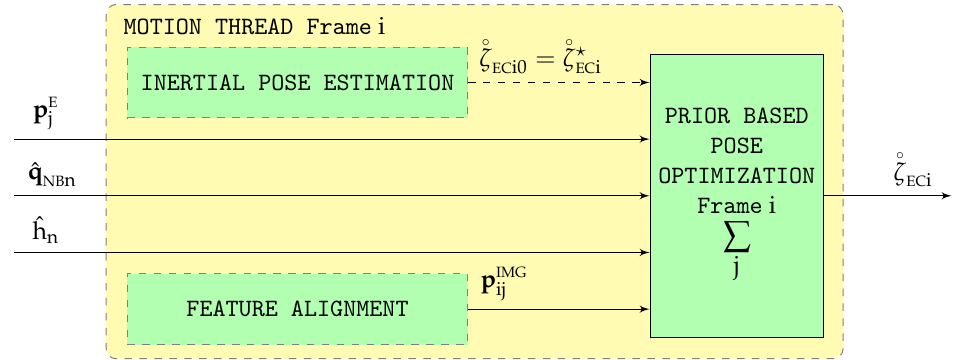
Figure 3. Prior-based pose optimization flow diagram.